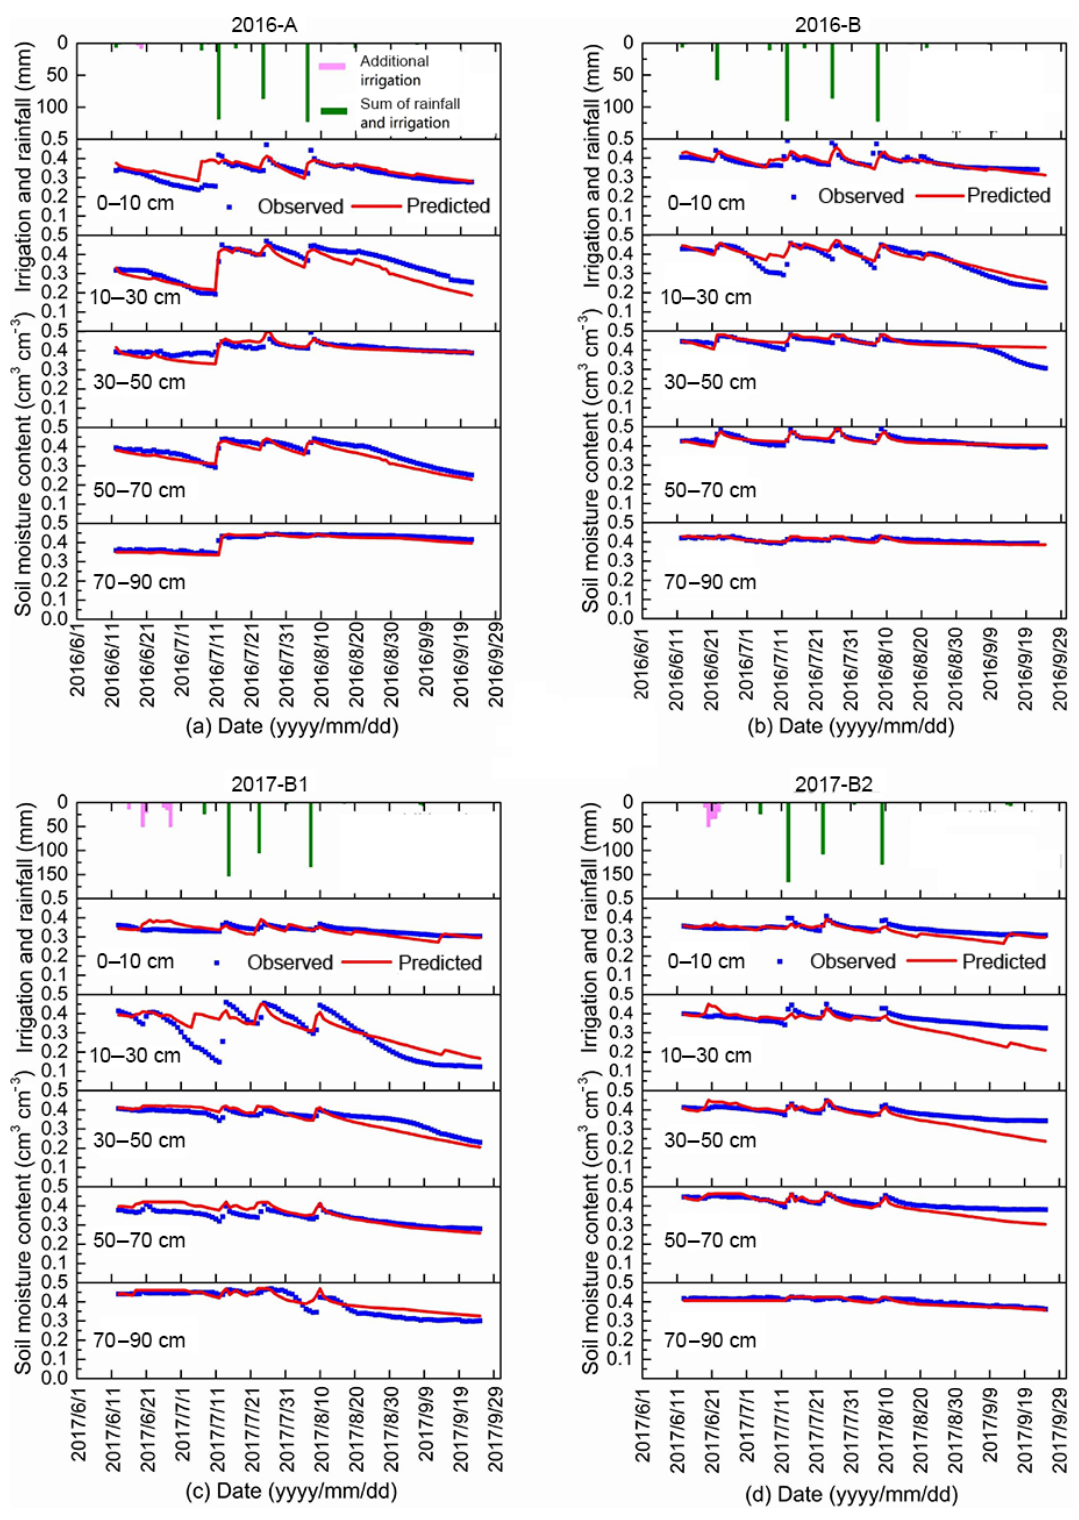
Figure 5. Simulated and observed soil moisture content for five soil depths during the growing period for the Fenzidi experimental fields in the Hetao irrigation district: (a, b) calibration in 2016 and (c, d) validation in